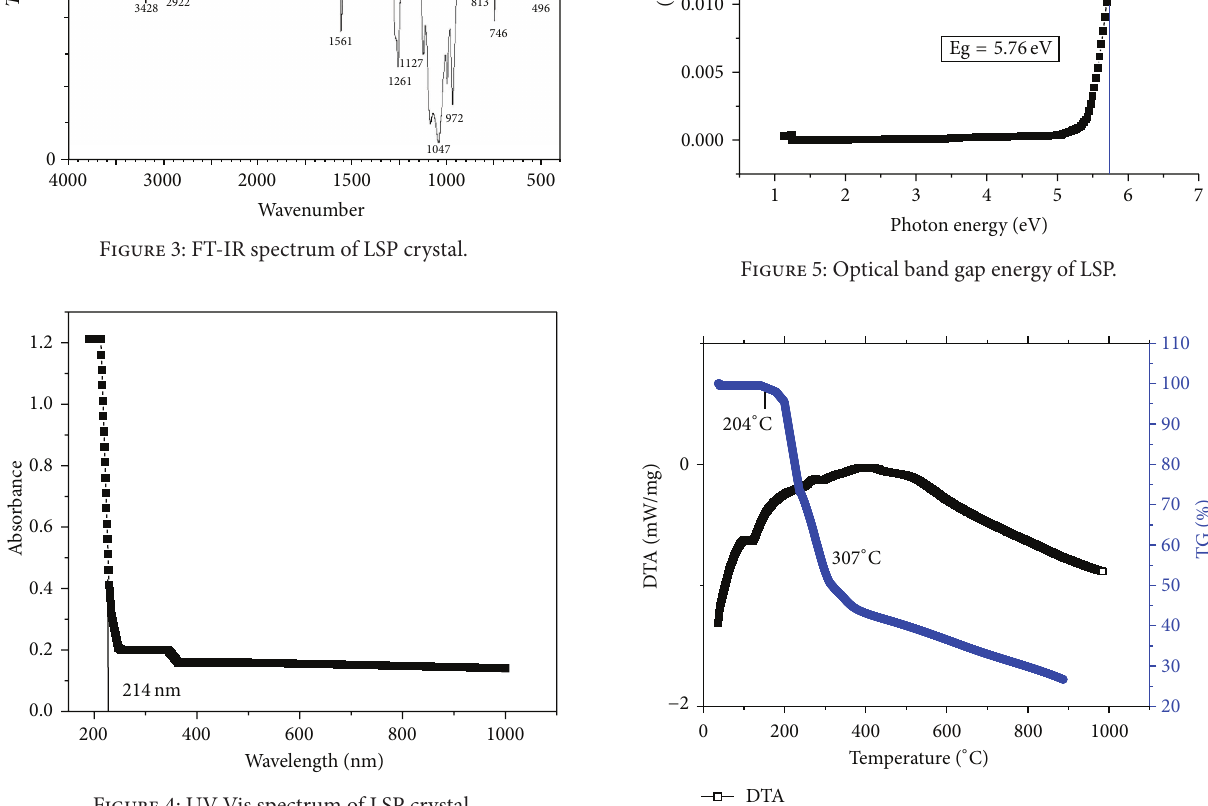
Figure 4: UV-Vis spectrum of LSP crystal.